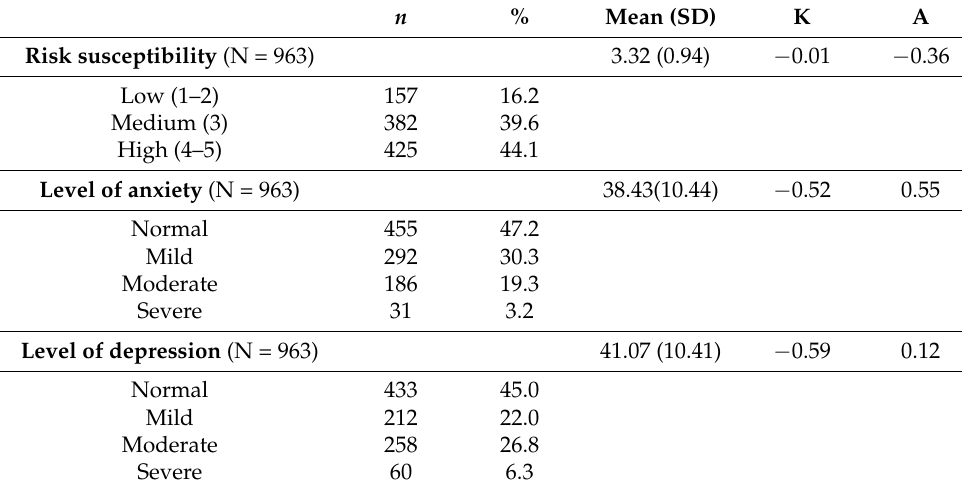
Table 3. Frequency distribution of